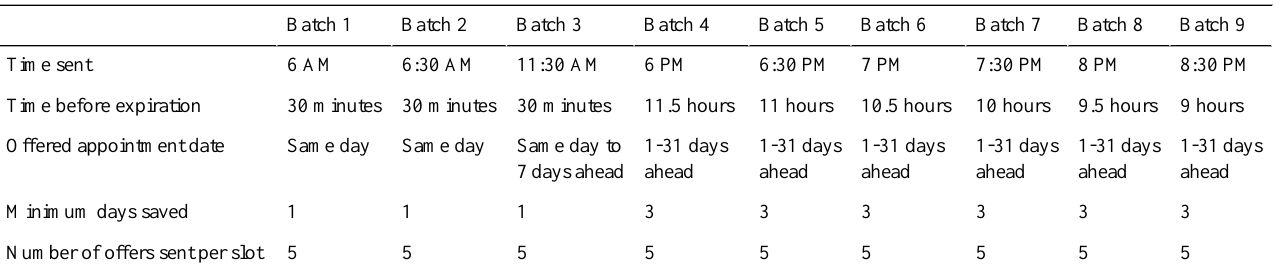
Table 1. Fast Pass offer